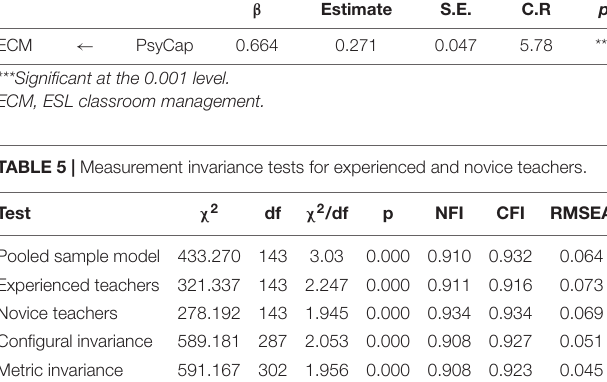
data: χ 2 /(979) = 1.956, p < 0.001, RMSEA = 0.045, CFI = 0.936, and GFI = 0.901.